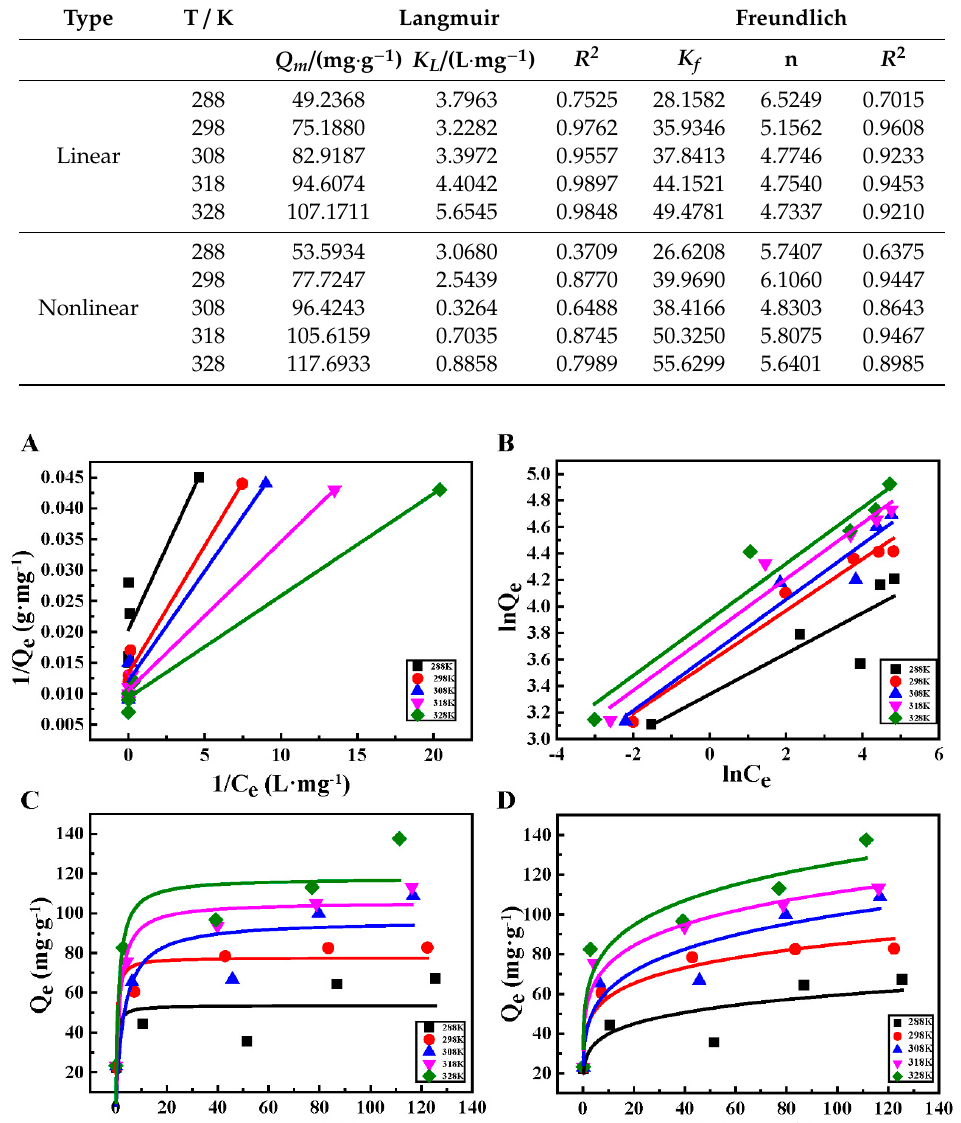
Table 2. Langmuir and Freundlich model parameters of HHTB adsorption Pb 2 + .